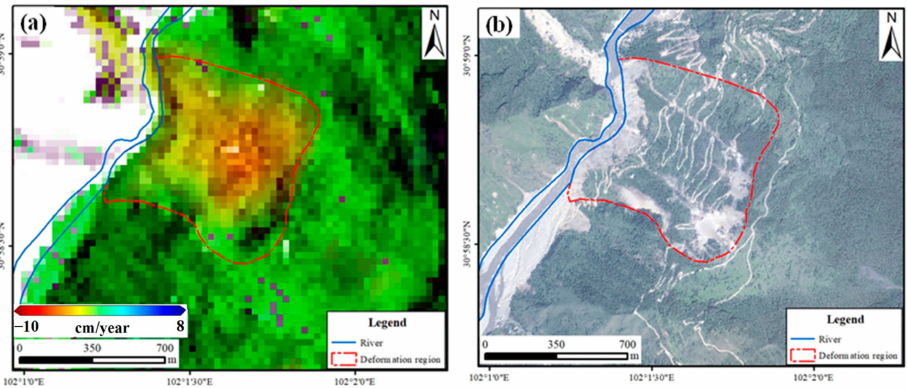
Figure 8. ( a ) Deformation map of the surface area from InSAR. ( b ) Optical satellite image of the ground deformation area on 27 August 2020.